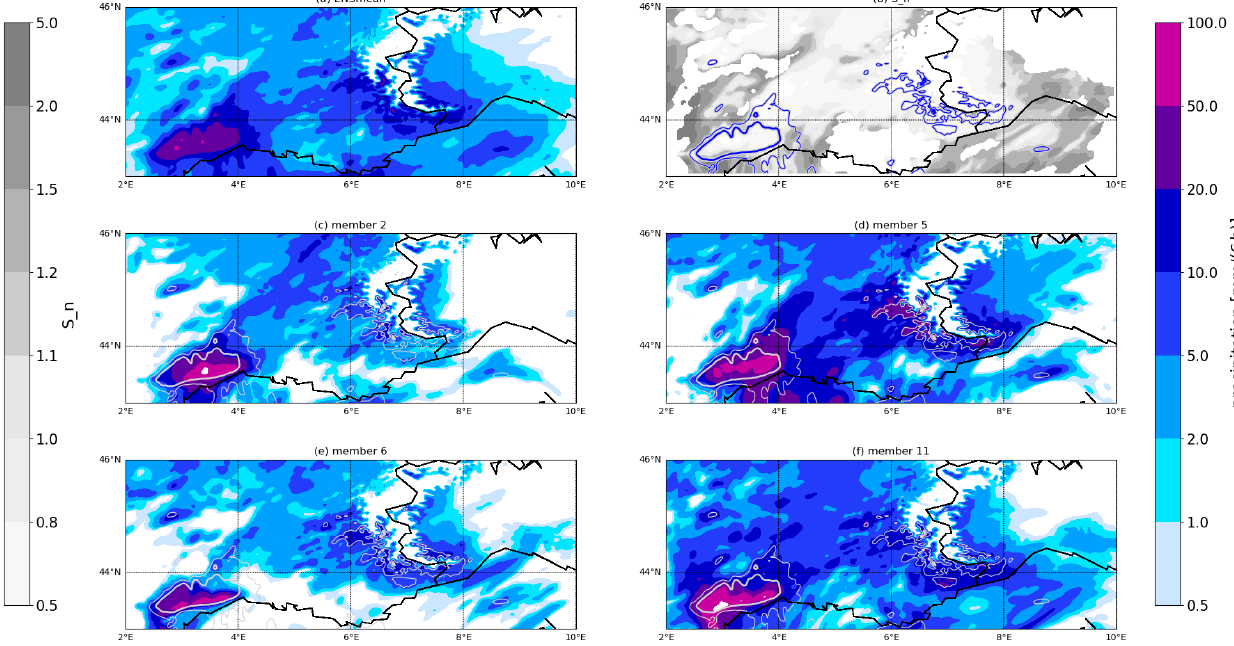
Figure 10. Same as Fig. 7, forecast for 13 October 2016 18:00UTC (initialized 12 October